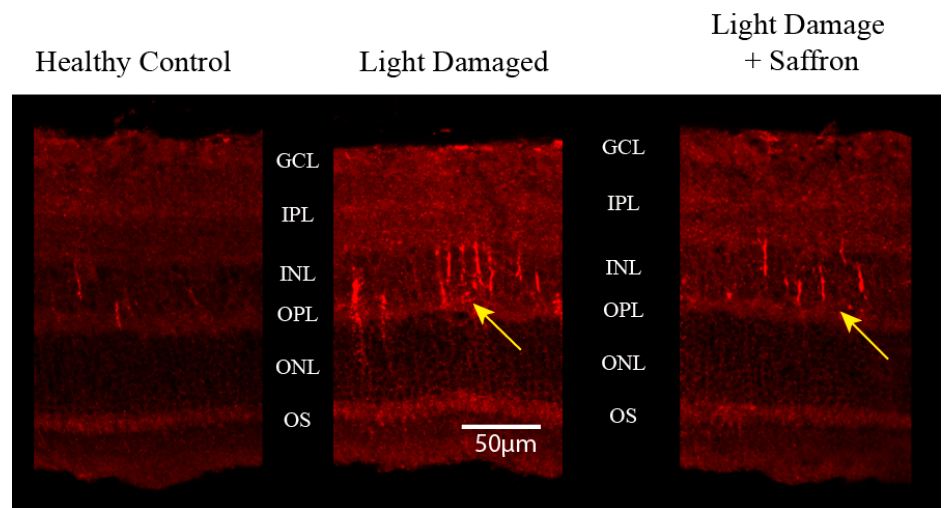
Figure 6. MMP-3 immunoreactivity in the different experimental models: Healthy control (Left), Light Damaged (Center) and Light Damaged with saffron supplementation (Right). Animals were sacrificed at the end of light exposure. OS = photoreceptor outer segments; ONL = outer nuclear layer; OPL = outer plexiform layer; INL = inner nuclear layer; IPL = inner plexiform layer; GCL = retinal ganglion cell layer.